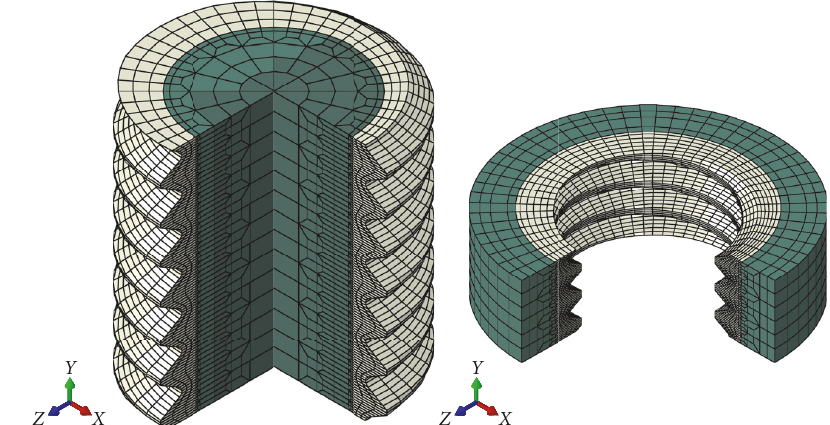
Figure 6: The hexahedral models of threads.